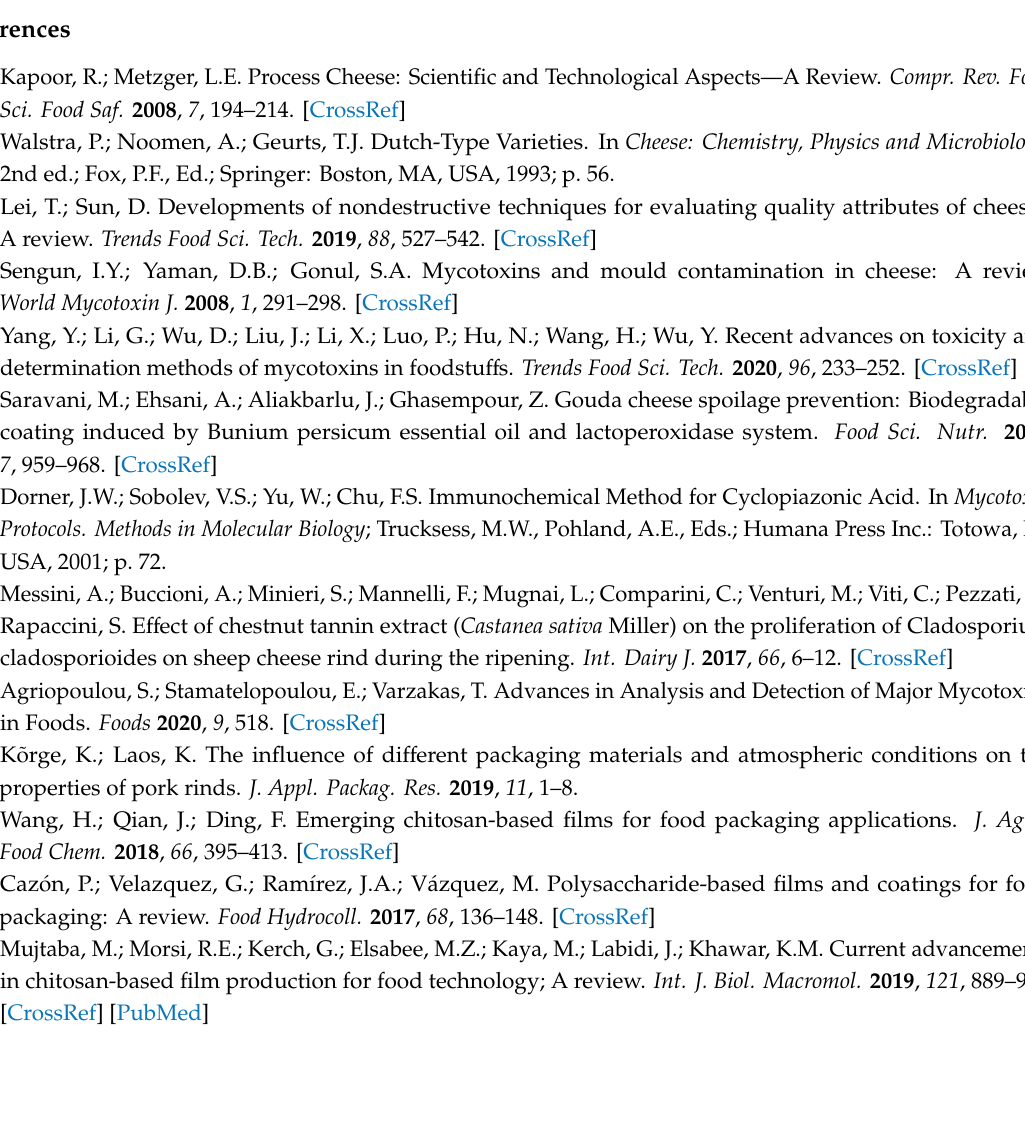
fluorescens and P. commune, Table S2: The e ff ect of biopolymer film (CH, TA:CH, CE:CH) on CPA production in cheese (0.5 g), compared with mycotoxin accumulation in films (2 × 2 cm) during storage at 4 ◦ C and 25 ◦ C. Slash-marked spaces depict missing parallels for CH and CH:CE samples and inability to record results for TA:CH and iTA:CH. Calculations in µ g / kg are expressed per 1 g of the sample, Table S3: The e ff ect of biopolymer film (CH, TA:CH, CE:CH) on pH in cheese, compared to simultaneous pH change in films (2 × 2 cm) at 4 ◦ C and 25 ◦ C, Figure S1: Mechanical properties of films used for packing Gouda cheese, Figure S2: Total phenolic content of films used for packing Gouda cheese. Gallic acid was used as a standard, and the results were expressed as the mass of gallic acid equivalent (GAE) per mass of the film, Figure S3: UHPLC chromatograms of iTA:CH (film) inoculated with P. commune ( (cid:4) ) and 0.025 mg / L CPA standard ( (cid:4) ). Spectra depict possible shadowing complex formation between the CPA- and TA- containing samples, Figure S4: Gouda cheese packed in CH, TA:CH and CE:CH biofilms (from left to right), Figure S5: The appearance of the cheese at the beginning (day 0) and the end of the storage (after 37 days, for all the other